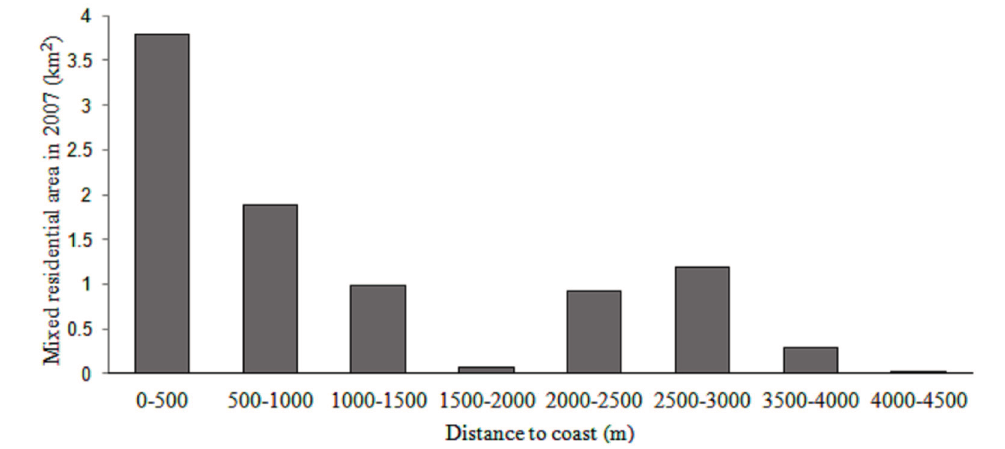
Figure 7. Areas developed for residential uses up to 2007 in relation to the distance to the